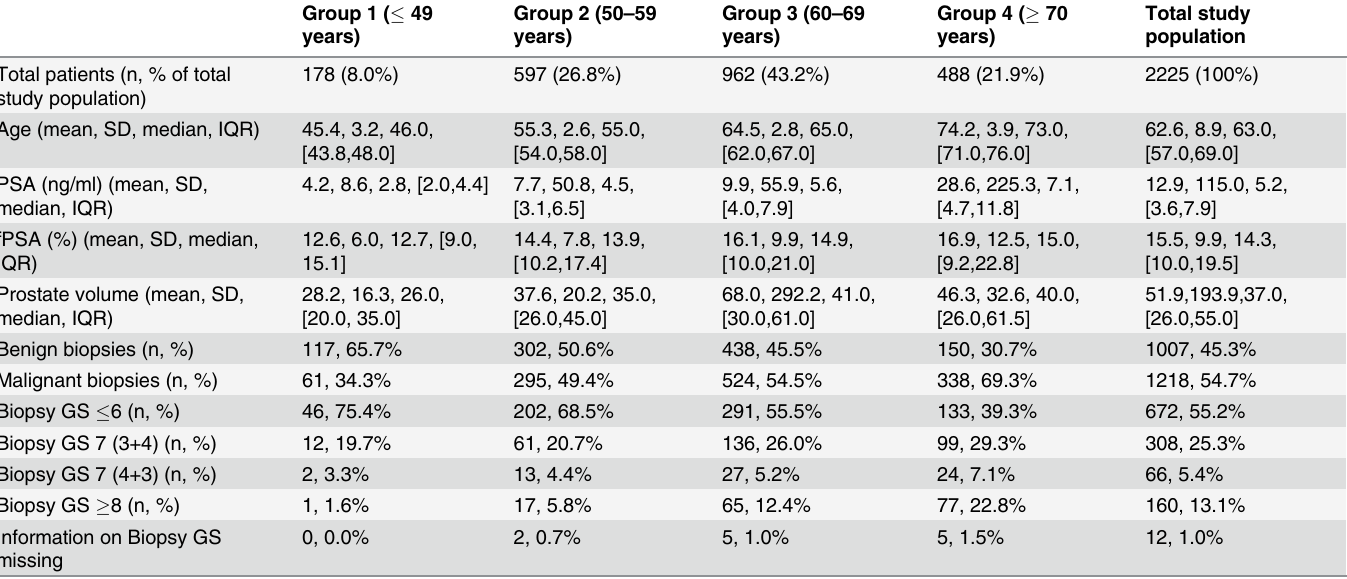
Table 1. Clinical and demographic characteristics of the study population stratified by age. Group 1 ( (cid:1) 49